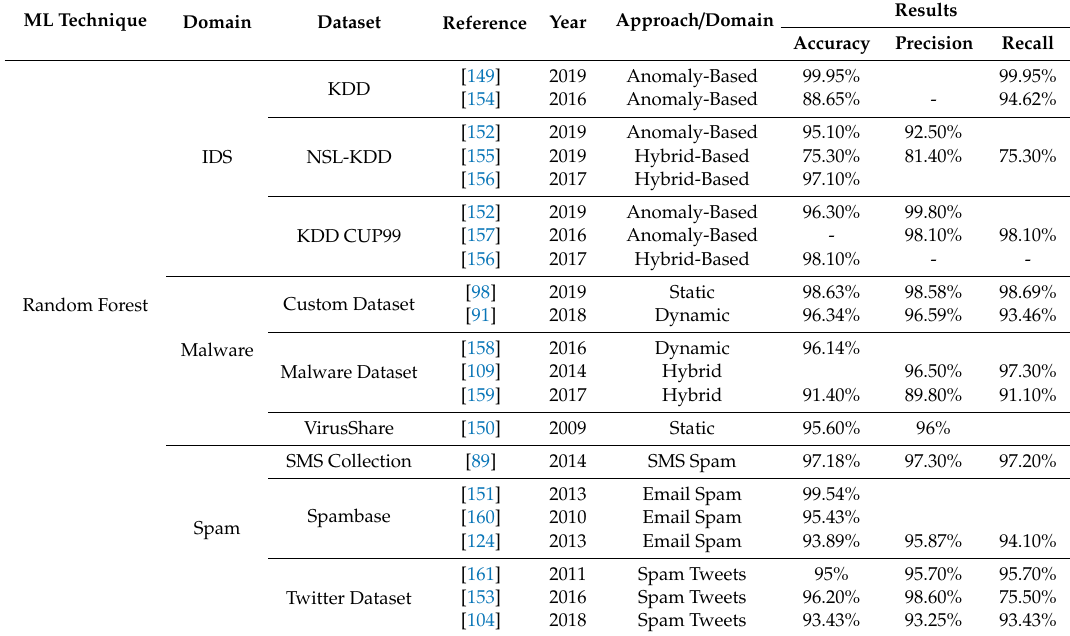
Table 8. Evaluation of Random Forest in